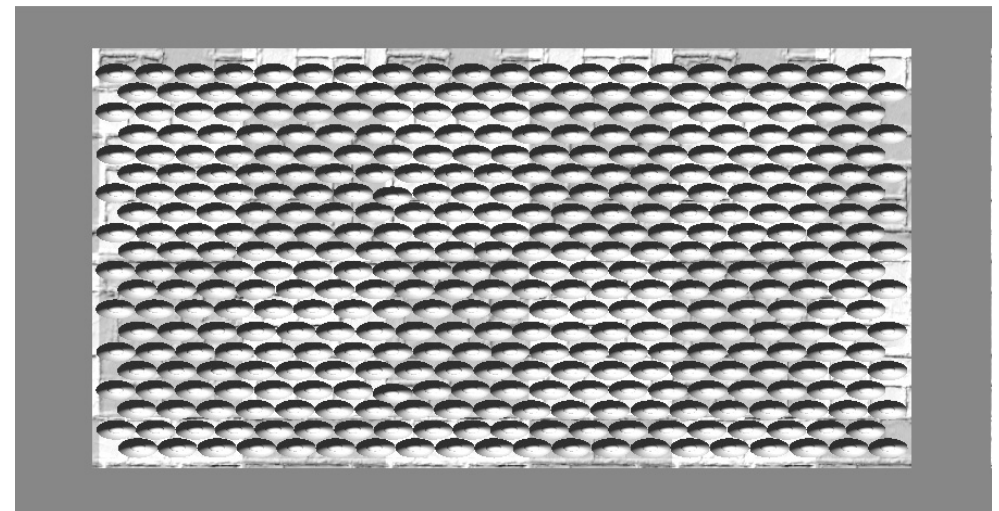
Figure 11. A total of 400 agents are packed hexagonally with three fixed walls, while the wall at the bottom moves upward in the simulation.